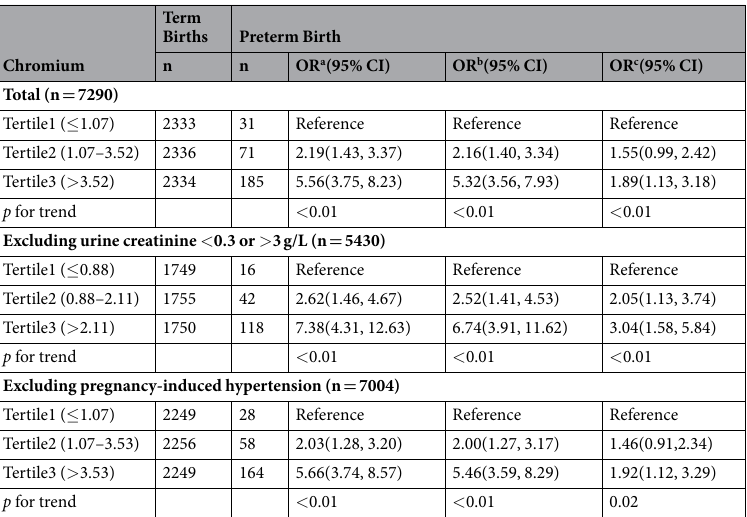
Table 3. Logistic regression analyses of the association between maternal urinary chromium ( μ g/g cr) and preterm birth. Abbreviations: CI, confidence interval; OR, odds ratio. a Unadjusted odds ratio. b Adjusted for maternal age, educational level, BMI, parity, and pregnancy-induced hypertension. c Adjusted for maternal age,